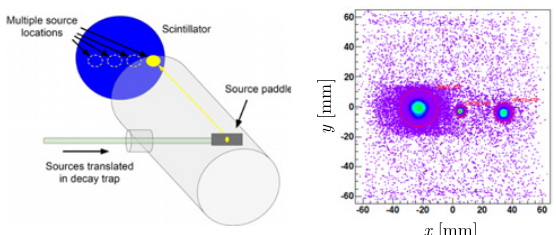
Figure 3. Left: illustration of the “load lock” source insertion system, which permitted sealed sources to be translated across the detector face with the spectrometer under vacuum. Right: example of a reconstruction by the MWPC of the transverse ( x , y ) positions of three different calibration sources (left to right: 207 Bi, 139 Ce, and 113